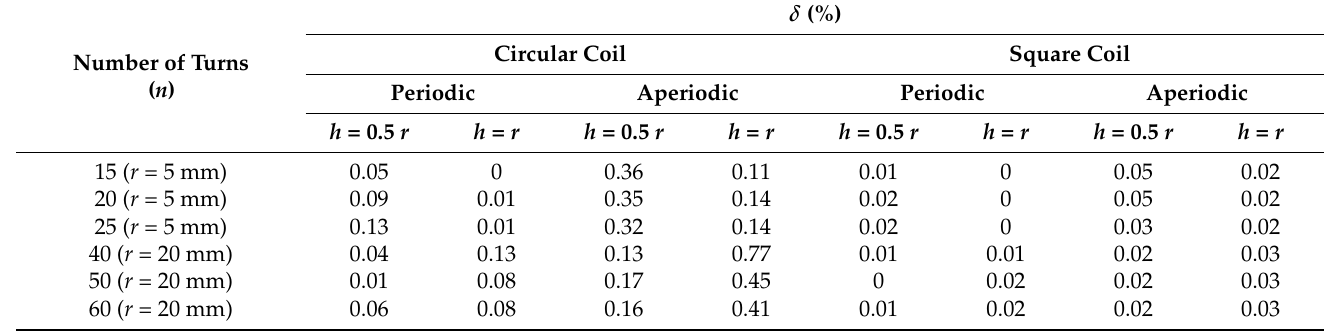
Table 9. The values of the absolute error calculated for power transfer efficiency at all frequencies and cases.